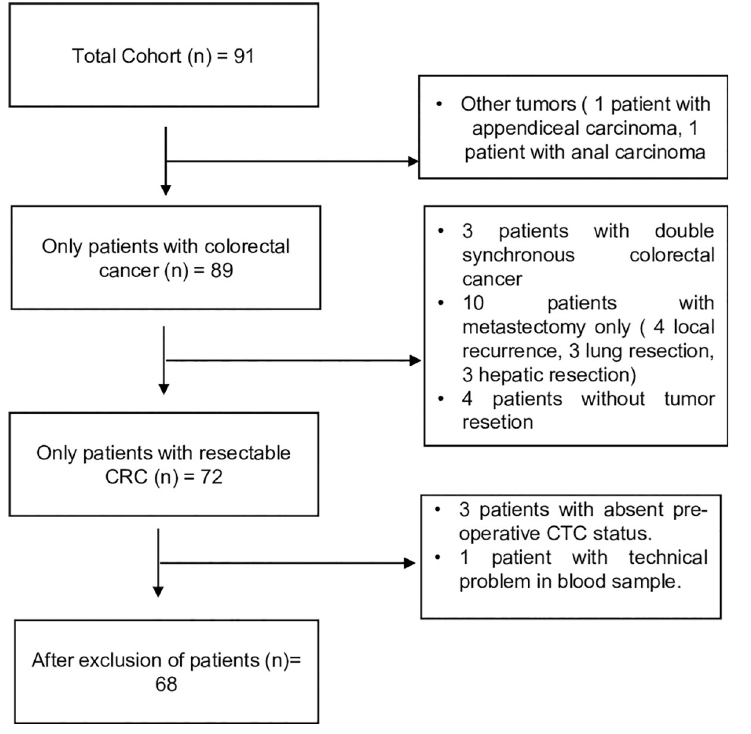
Fig 1. Flow chart. Process of patient